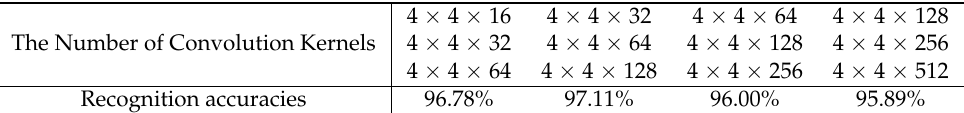
Table 4. Recognition accuracies vs. Number of convolution kernels.